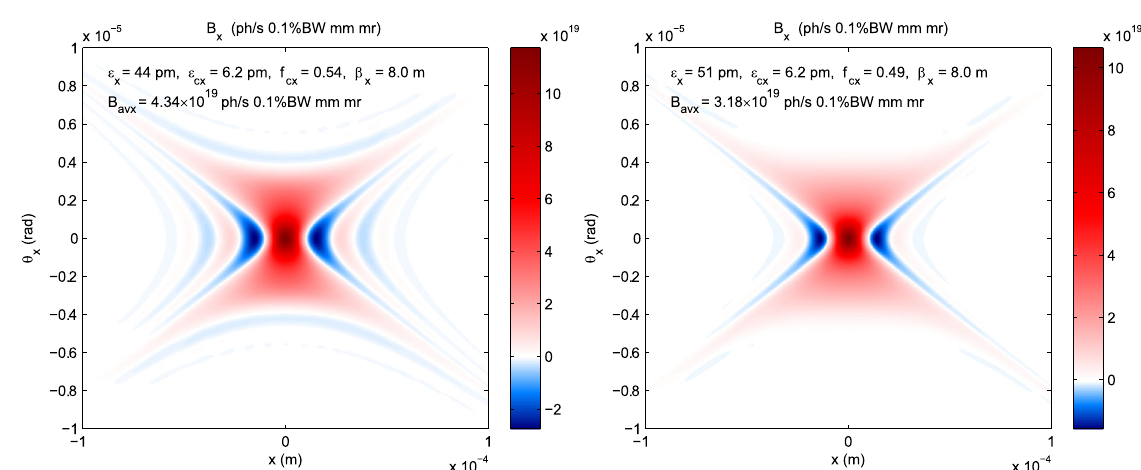
FIG. 20. X-ray phase space corresponding to zero emittance and zero energy spread (left) and nonzero energy spread (cid:12) 2 (cid:1) 10 (cid:2) 4 (right). The beam current is 100 mA.